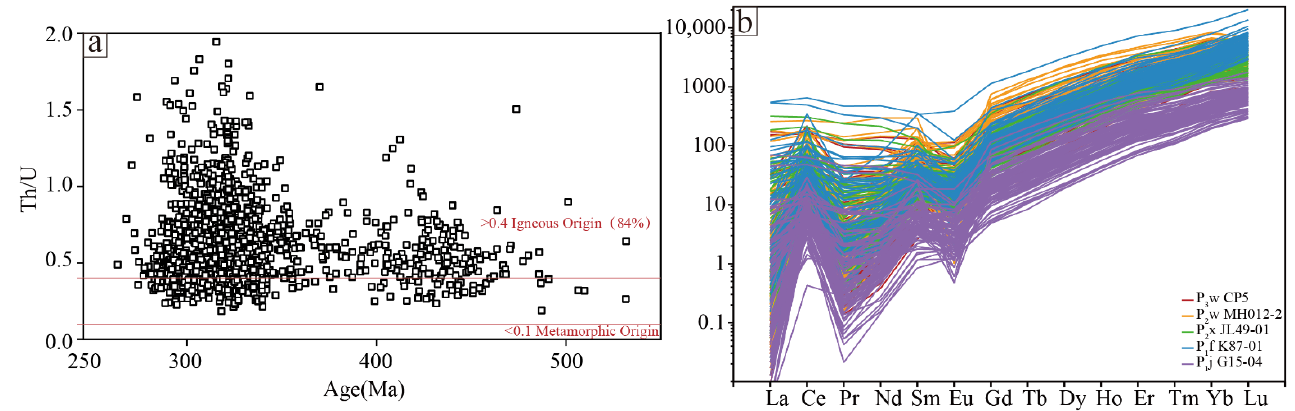
Figure 5. ( a ) The plot of Th/U ratios versus zircon U–Pb ages of detrital zircons from detrital samples in Permian deposits from the Mahu-Zhongguai area, northwestern Junggar Basin. ( b ) The chondrite-normalized REE patterns for zircons of magmatic origin for typical Permian samples from the Mahu-Zhongguai area, northwestern Junggar Basin.The values of chondrite are from [79].